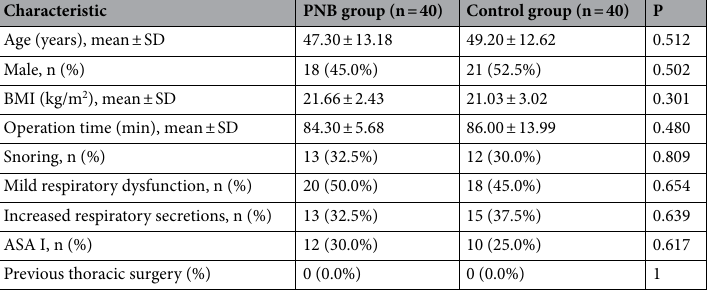
Table 1. Baseline demographics of the participants. BMI body mass index, PNB phrenic nerve block, SD standard deviation.